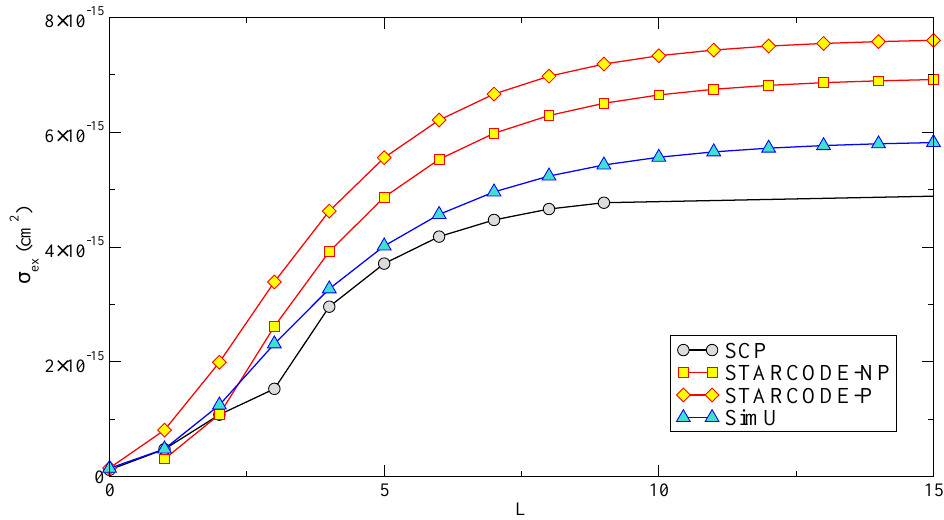
Figure 6. Li I 2 s − 2 p cumulative partial excitation cross-section as a function of L , for an energy equal to 5eV.